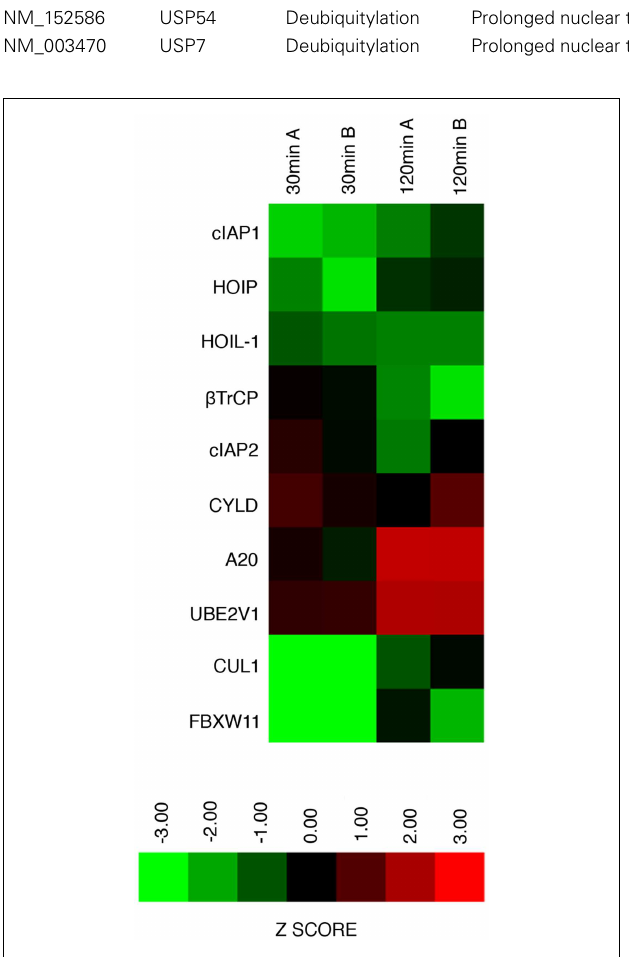
FIGURE 3 | Graphical representation of replicate assay z -scores assigned to known ubiquitin ligase modifiers of theTNF–NF- κ B pathway in the primary siRNA screen .